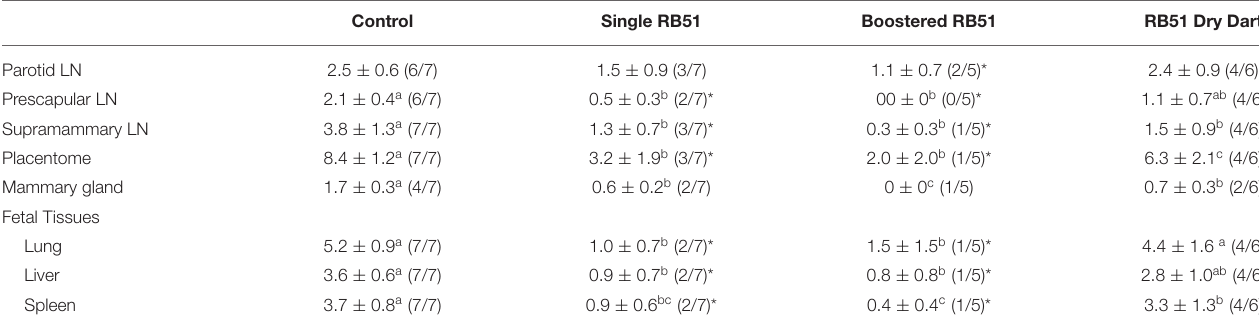
TABLE 2 | Log 10 colonization (colony-forming units (CFU)/gm) of S2308 in tissues at necropsy after conjuctival challenge with 10 7 CFU of B. aboruts in